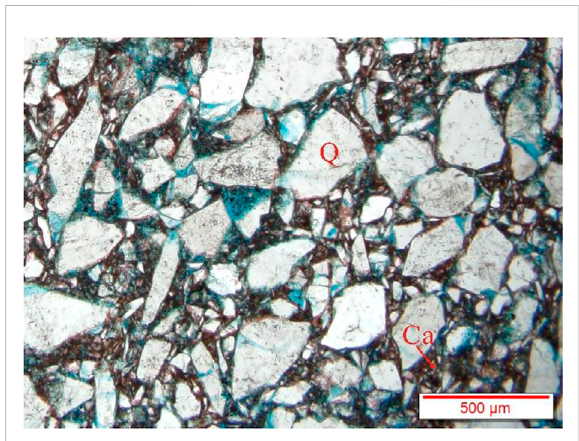
FIGURE 1 Microscopic characteristics of a typical manufactured calcite-cemented sandstone. The letters Ca and Q in the image stand for calcite and quartz, respectively. The pore space is fi lled with blue